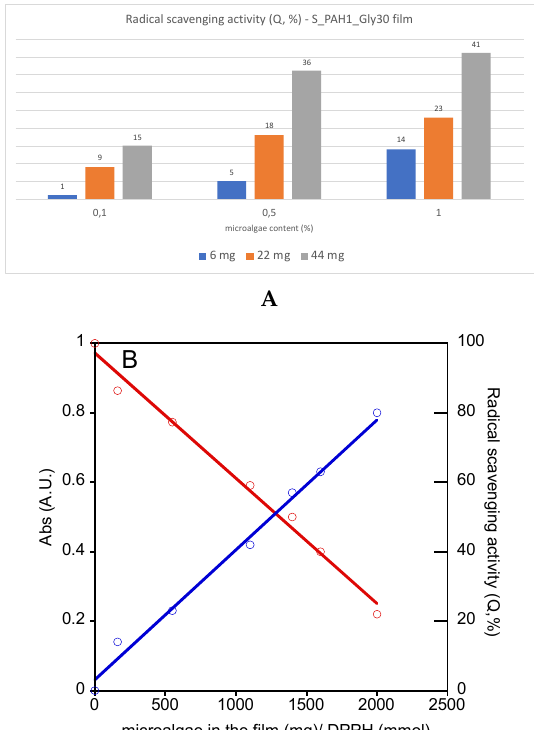
Figure 8. Radical scavenging activity (Q) of T. obliquus microalgae entrapped in the S_PAH1_Gly30 film as a function of microalgae content ( A ); Double Y plot for the determination of the EC 50 value of the S_PAH1_Gly30_1 film ( B ).